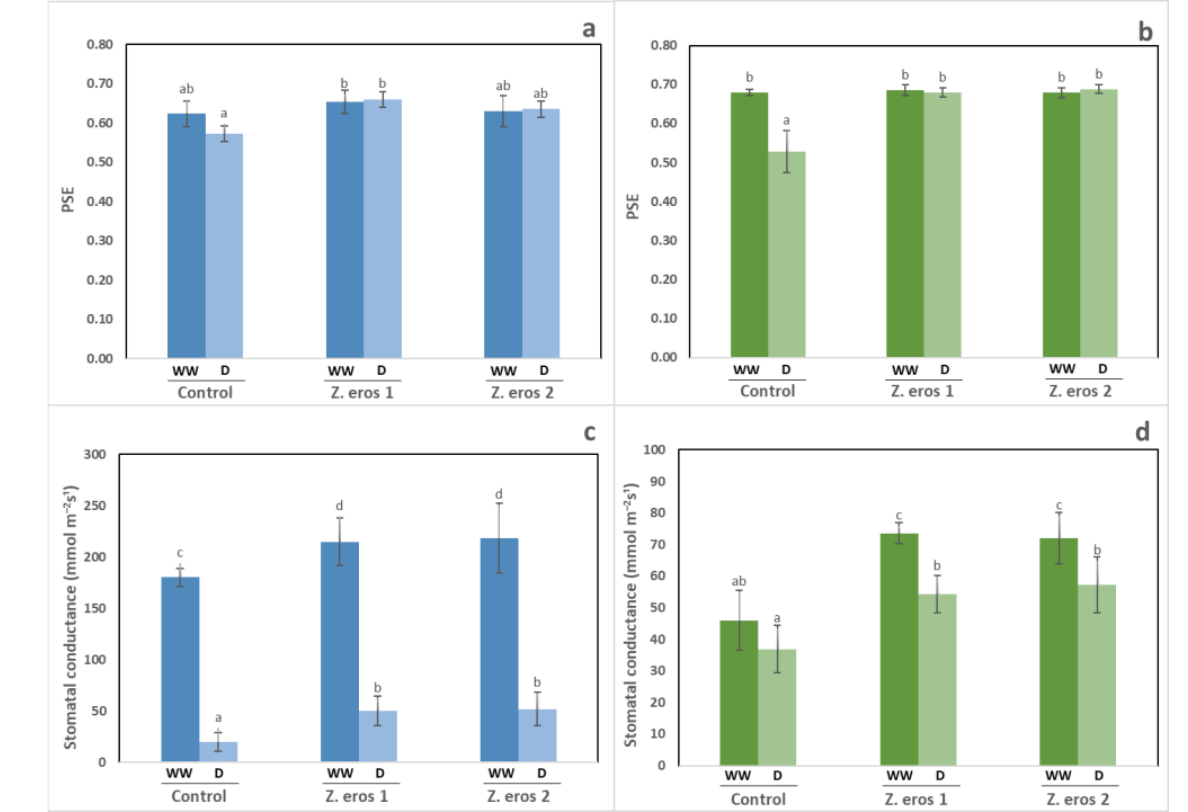
Figure 3. Photosynthetic efficiency (photosystem II) and stomatal conductance in wheat ( a , c ) and tomato ( b , d ) plants inoculated with the fungal endophytes Z. erostrata 1 y Z. erostrata 2 and cultivated under well-watered (WW) or drought stress (D) conditions. The data are the means ± standard deviation of four replicates. According to Duncan’s multiple-range test ( p < 0.05), different letters indicate significant differences between all treatments.